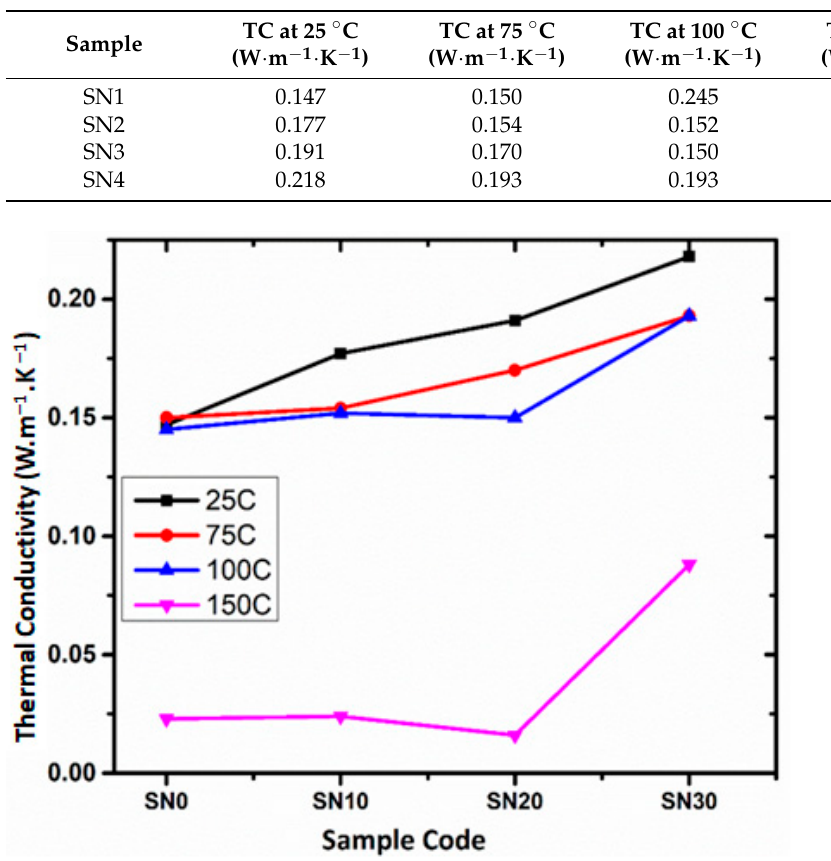
Table 4. Thermal conductivity (TC) values of polystyrene/m-BN composites at 25, 75, 100 and 150 ◦ C.